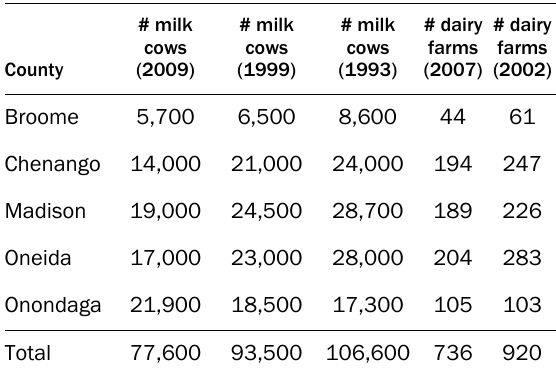
Table 2. Number of Milk Cows in Central New York, 1993, 1999, and 2009, and Number of Dairy Farms in Central New York, 2002 and